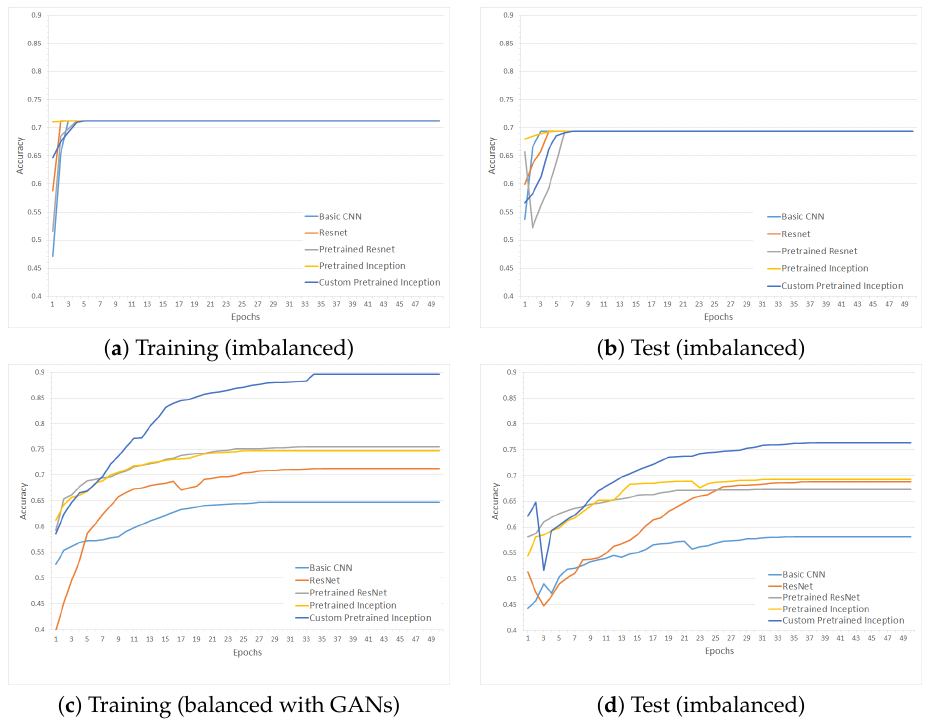
Figure 14. Accuracy of the different architectures on binary